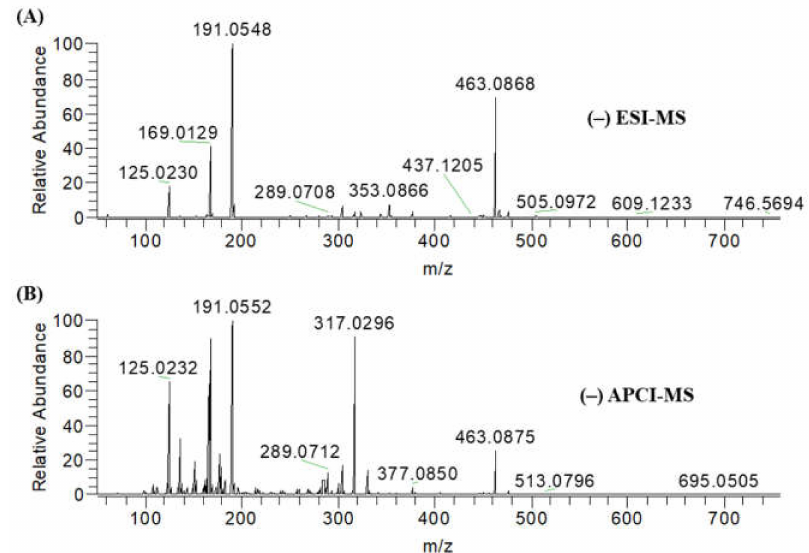
Figure 1. ( A ) Negative-mode electrospray ionization mass spectrometry (ESI–MS), ( B ) negative-mode atmospheric pressure chemical ionization mass spectrometry (APCI–MS) mass spectra of ethanol extracts of M. zapota leaves (ZLE). Prepared sample was directly infused to ESI and APCI